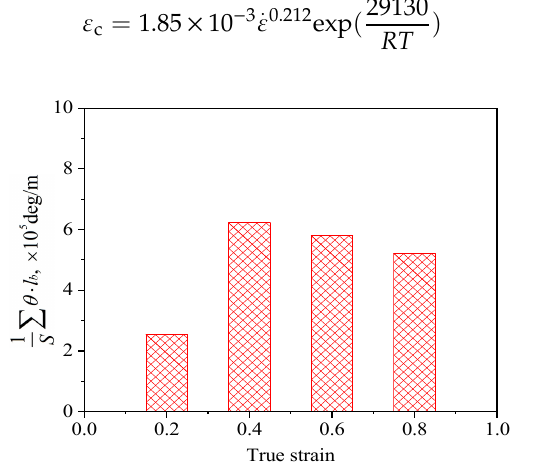
(cid:80) θ × lb ) with true strain for the solution-treated S 1 θ×  l ) with true strain for the b S